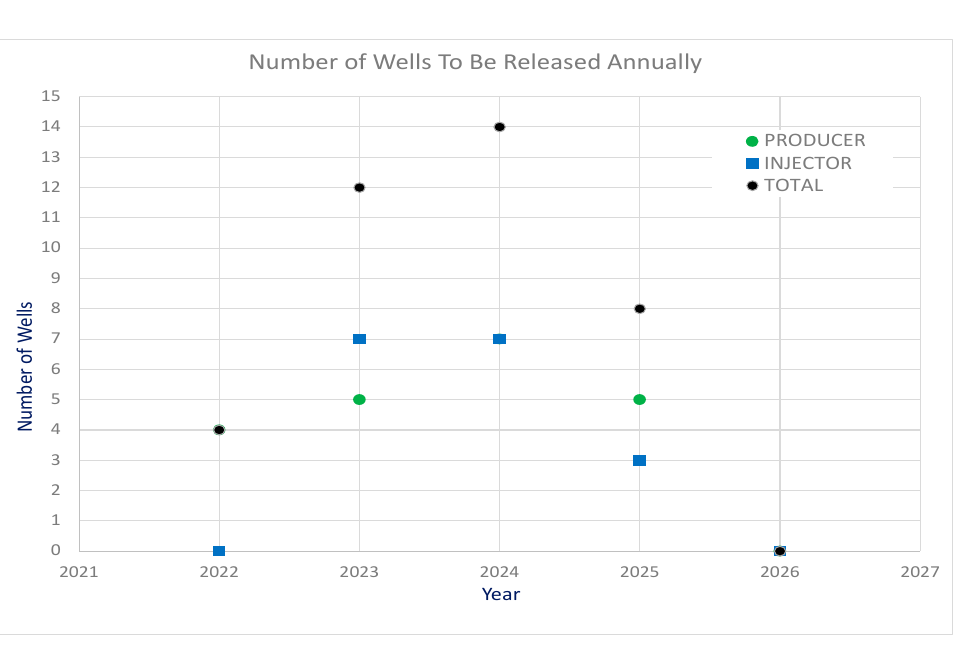
eau of 10,000 stbo/d for almost 1.5 years. At the end of the twelve-year forecast, the field will produce 18.7 MMstbo, which corresponds to a recovery factor of 28.8%. The total water produced is 51.8 MMstb and the total injected water is 70.6 MMstb. As was the case with the previous FDP solution, a supplementary source of water is needed. Half of the required injection rate will be available from the produced water after 3.8 years.